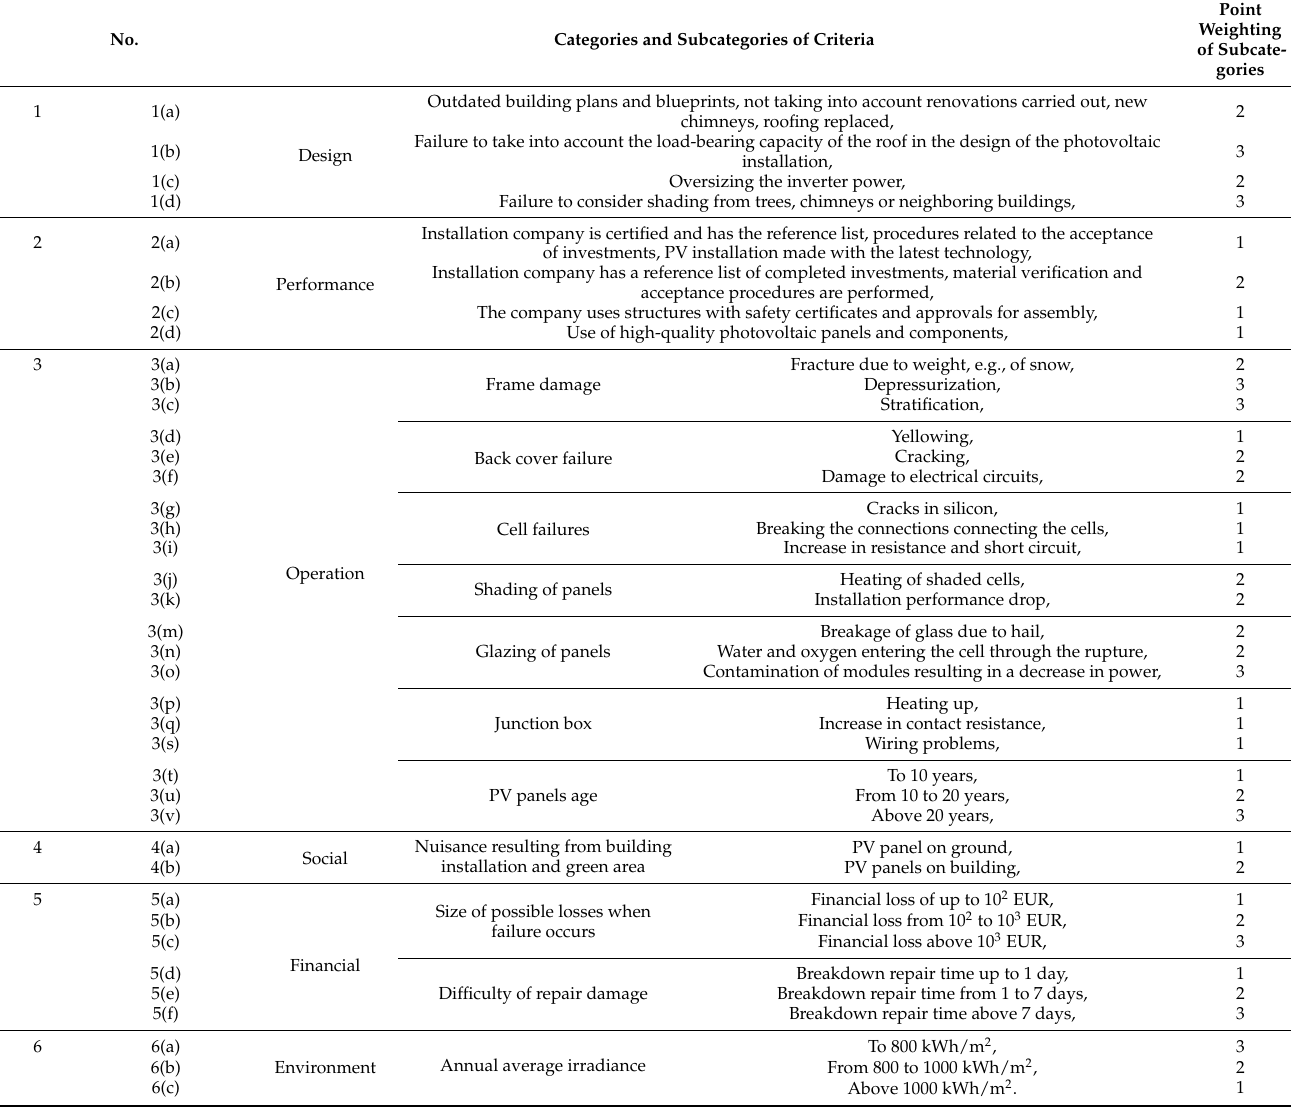
Table 4. Evaluation criteria